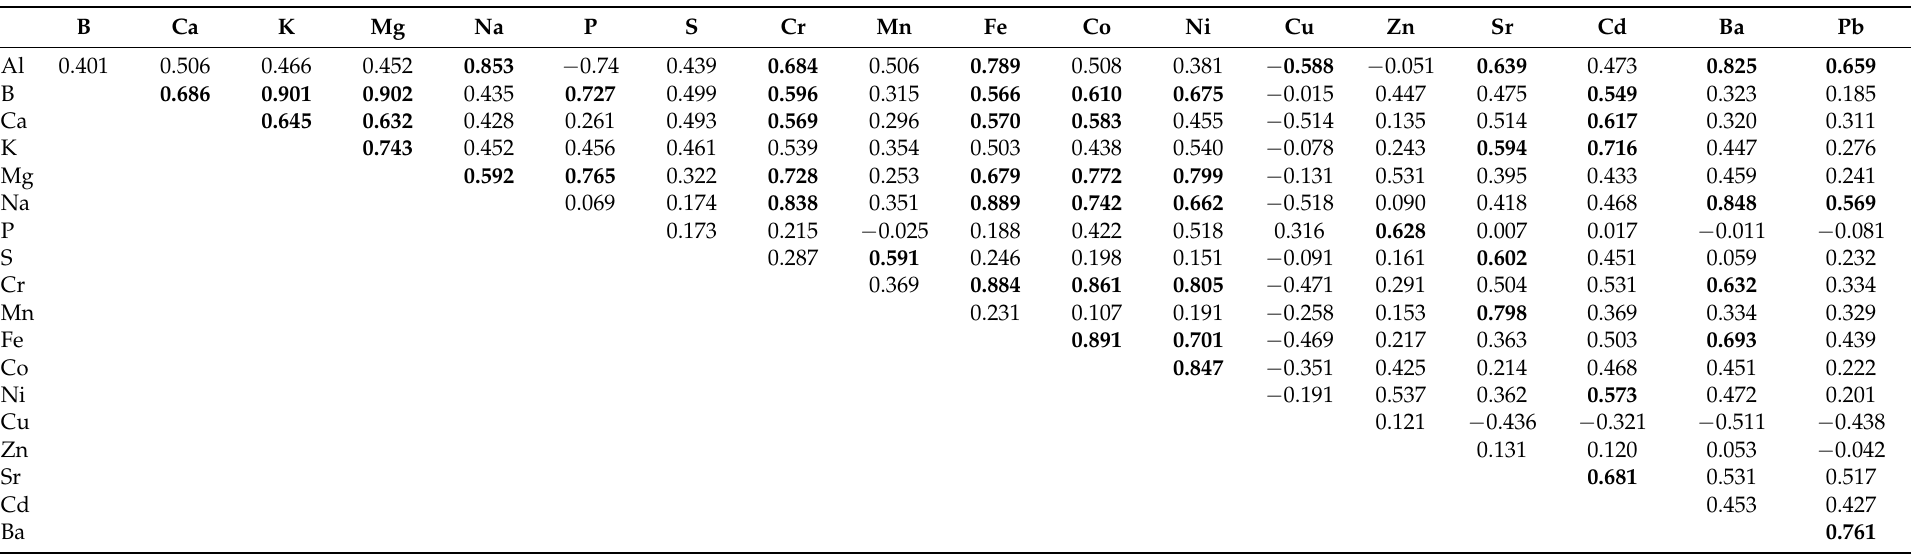
Table 10. Pearson correlation coefficients ( r ) amongst nineteen chemical elements of white wine from Debrecen-Pallag, Hungary. Bold figures represent the significant ( p < 0.05) correlation coefficient values among parameter